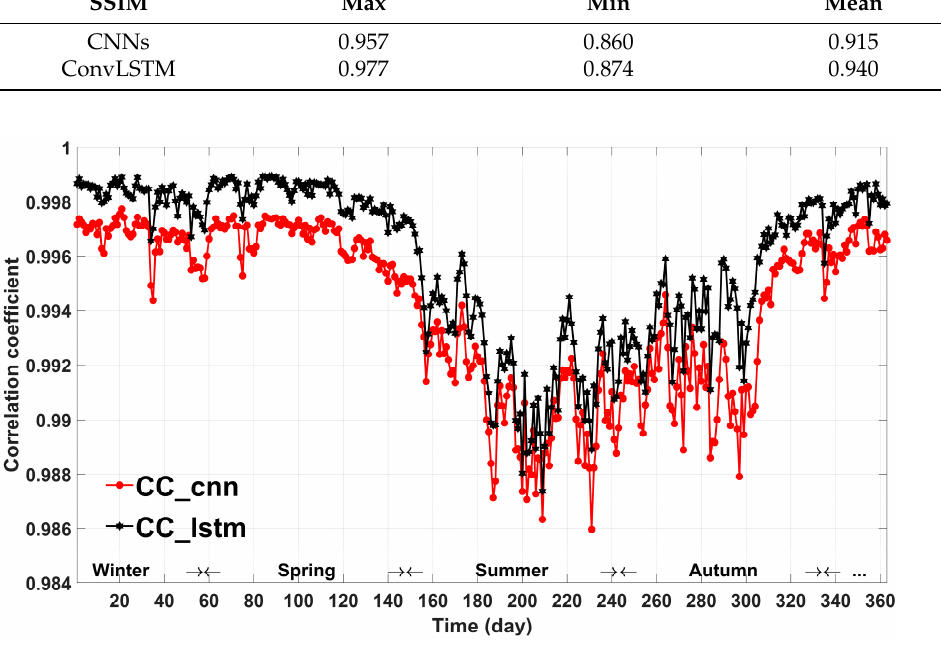
Figure 7. Comparison of the CC of the CNNs and ConvLSTM. The black line in the figure represents the CC of ConvLSTM, and the red line represents the CC of CNNs. Table 3. Comparison of the CC between the CNNs and ConvLSTM.